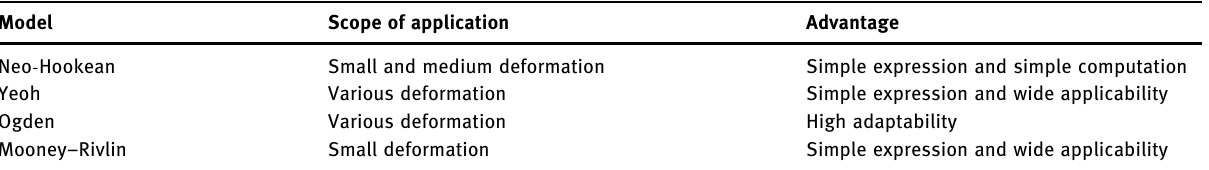
Table 1: Comparison of rubber constitutive